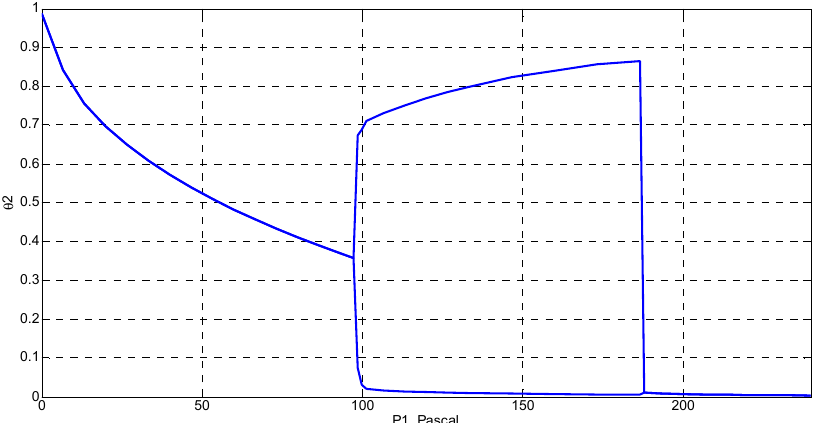
Figure 5. Amplitude values at stationary superficial fractional coverage of carbon monoxide versus carbon monoxide partial pressure [44].